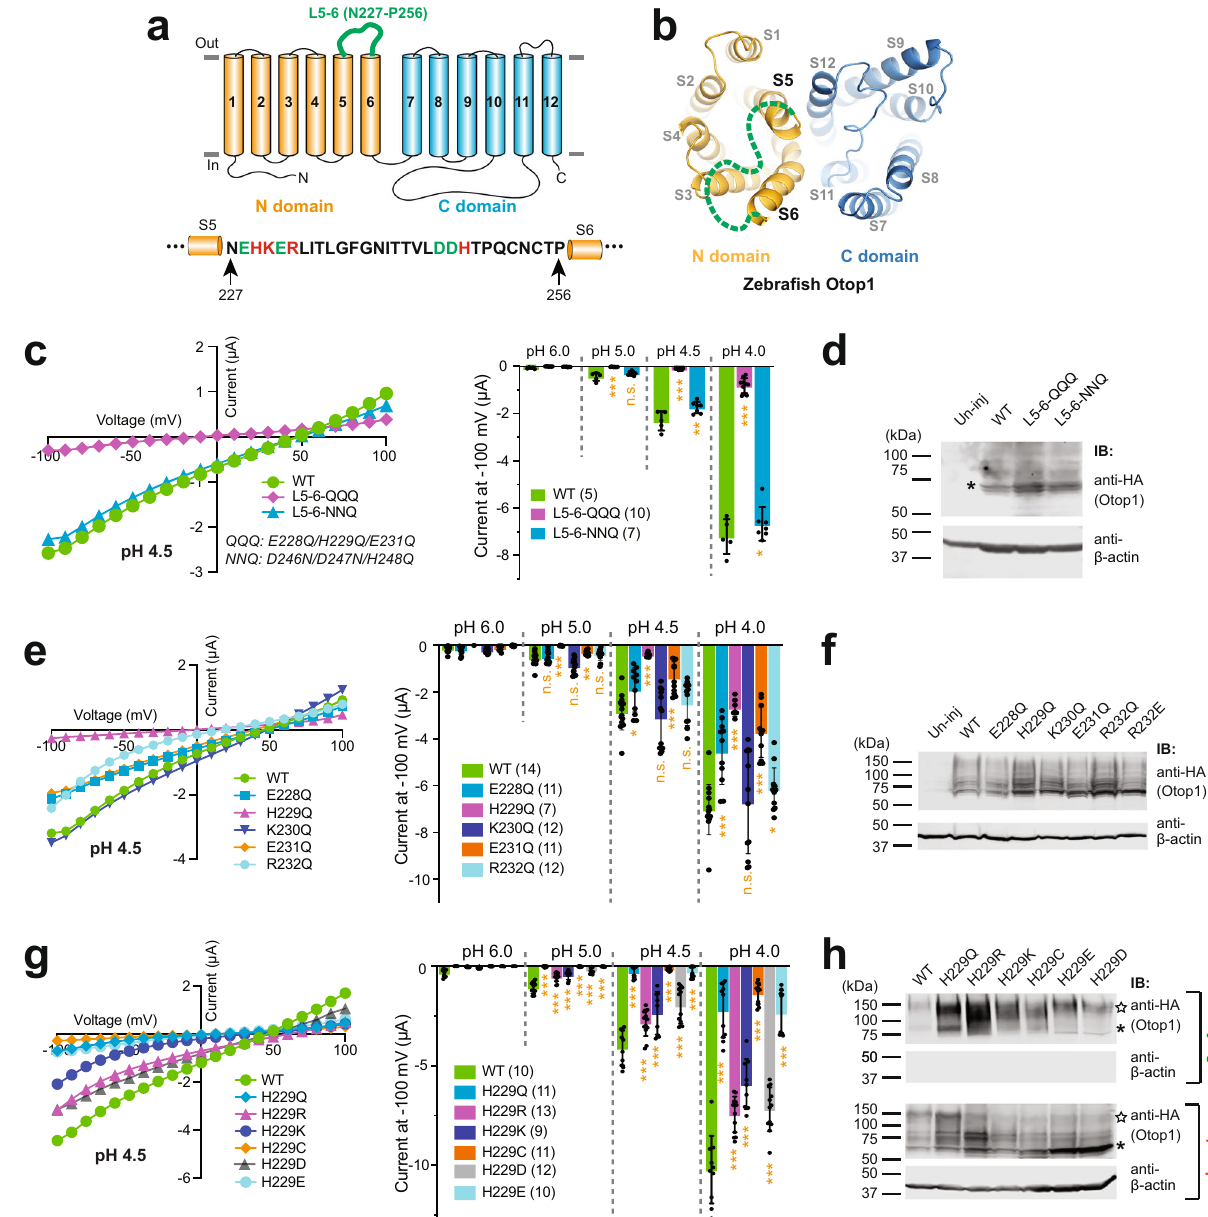
Fig. 2 H229 in the L5 – 6 is crucial for the function of the Otop1 channel. a Schematic illustration shows the locations of the L5 – 6 in the topology structure of Otop1. The amino acid sequence of the loop is provided at the bottom and the negatively and positively charged residues are in green and red, respectively. b The cryo-EM structure of the zebra fi sh Otop1 (PDB 6NF4) 23 . The S5 – S6 loop is not resolved in the structure and the green dotted line is utilized to label its relative position in the N domain. c , e , g Left: the representative I – V curves of the indicated WT and mutant Otop1 channels. Right: the scatter plot and bar graph showing the currents of the indicated channels recorded at − 100 mV at the indicated pHs. Data in the bar graphs are presented as mean ± SD. Currents of the mutants were compared to that of the WT with Student ’ s t -test (* P < 0.05, ** P < 0.01, *** P < 0.001, n.s.: no signi fi cance). Oocyte numbers for scatter plots and bar graphs are indicated in parentheses. d , f Western blot showing the expression of the indicated WT and mutant channels. h Western blot showing the overall expression (in lysate samples) and surface expression of indicated WT and mutant channels. Surface proteins were puri fi ed by surface biotinylation. The asterisks and stars show the monomer and dimer bands of Otop1,